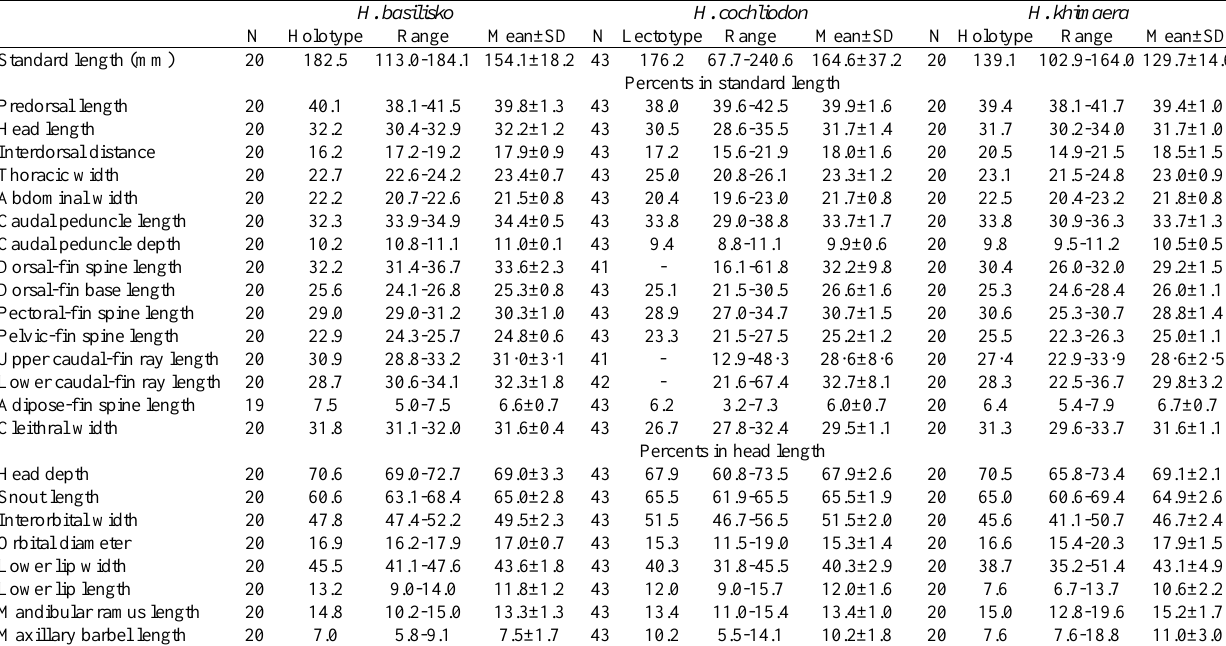
Tabela 1. Morphometric data of Hypostomus basilisko , H. cochliodon and H. khimaera. S.D.= standard deviation and n = number of measured